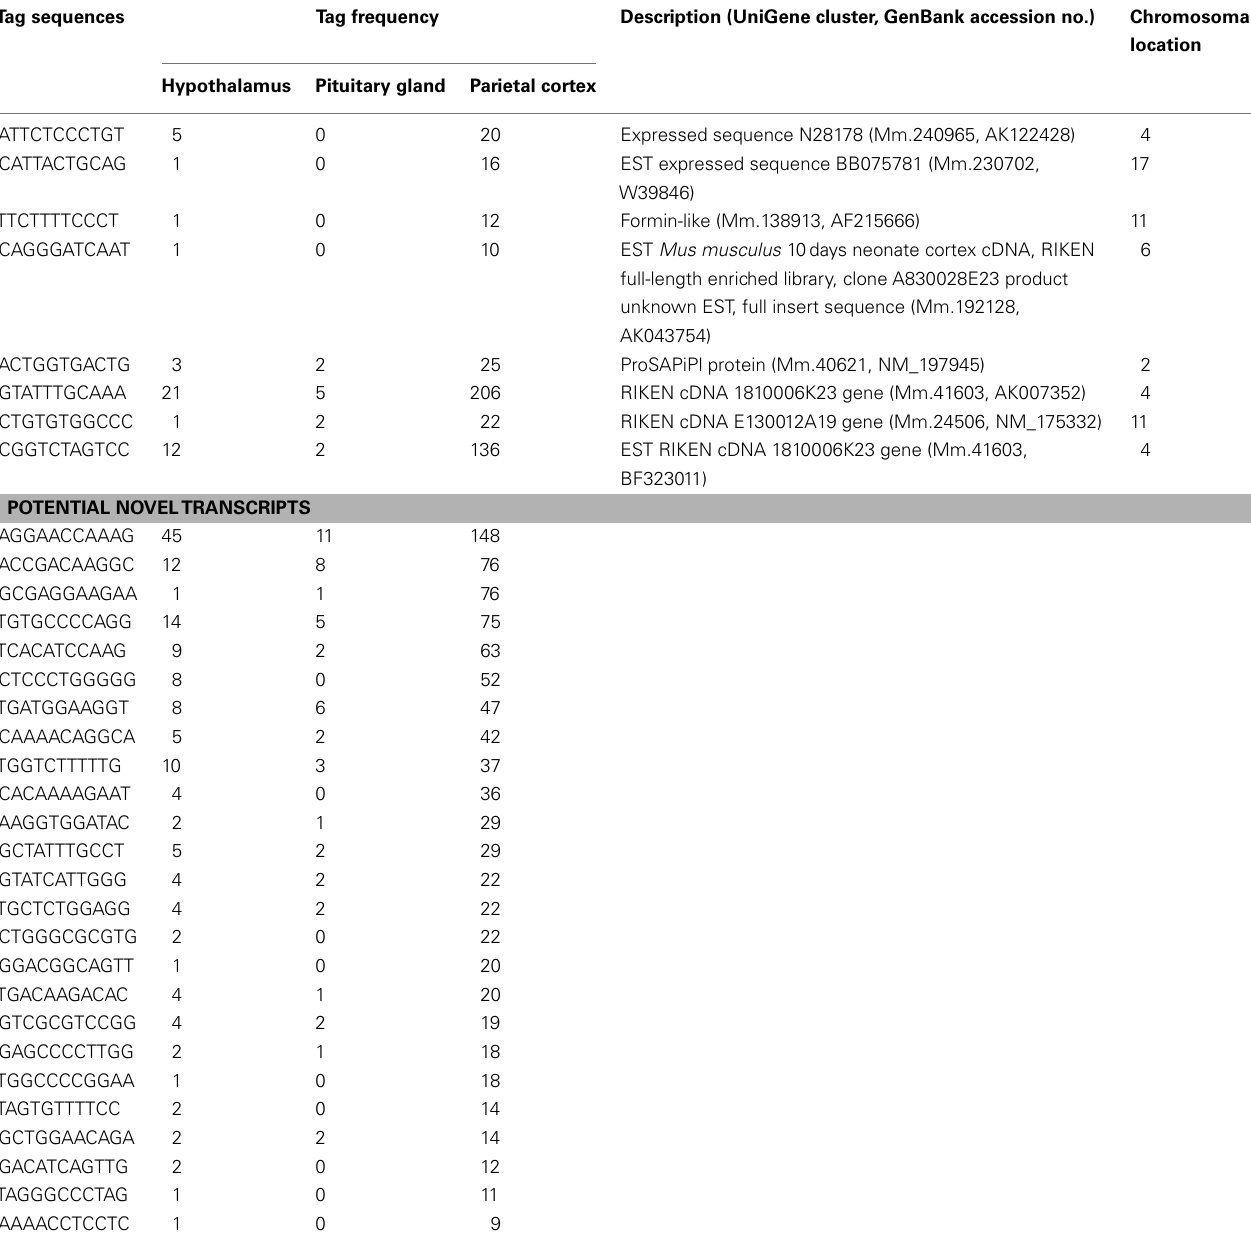
TableA4 | Unclassified transcripts preferentially expressed in the parietal cortex. Tag